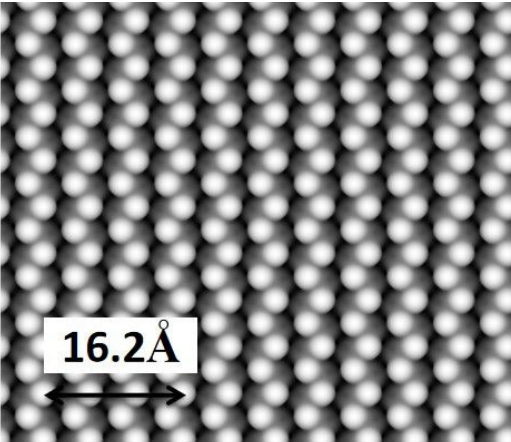
Figure 3. Simulated STM image of pyrite (001) with DFT